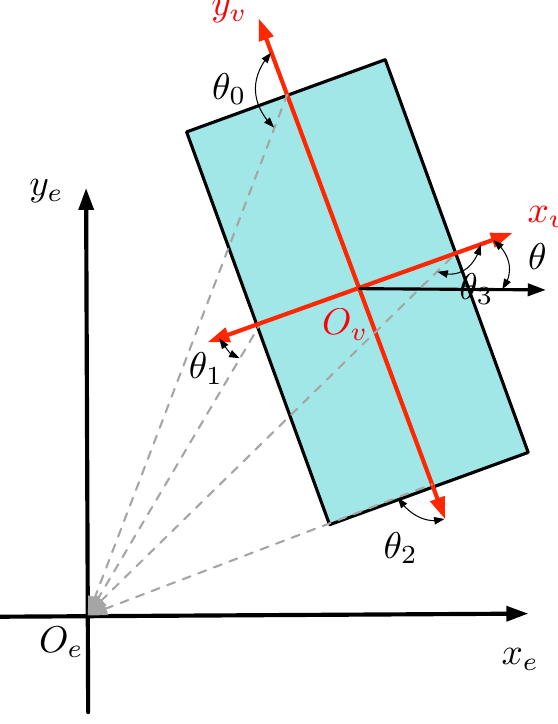
Figure 3. Rectangular model of the